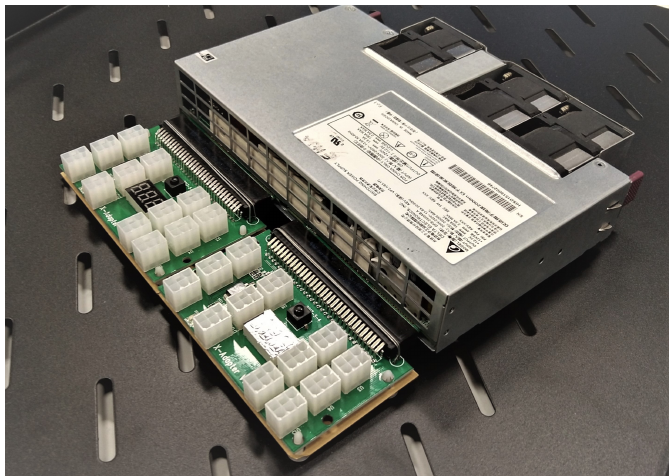
Figure 1. 2400 W single-phase power-supplying unit.